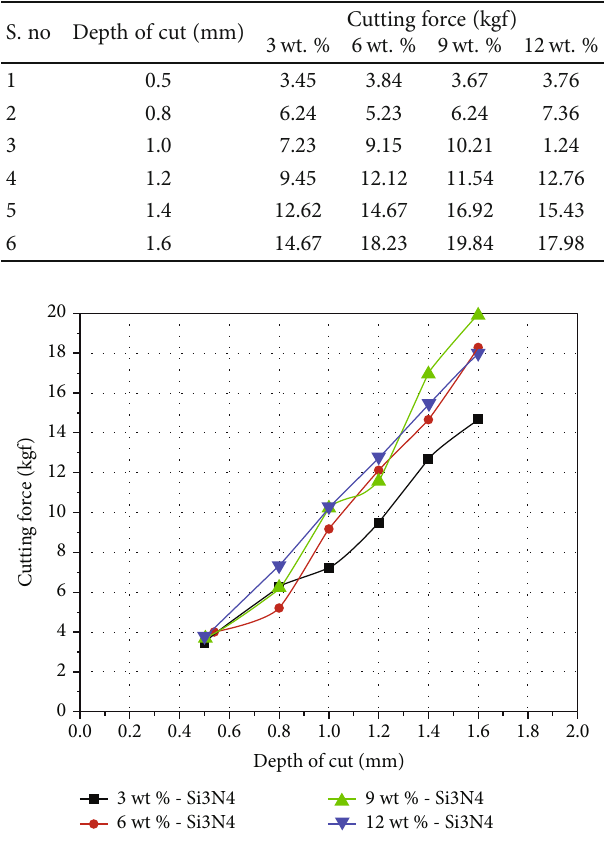
Figure 8: Cutting speed vs. cutting force (depth of cut